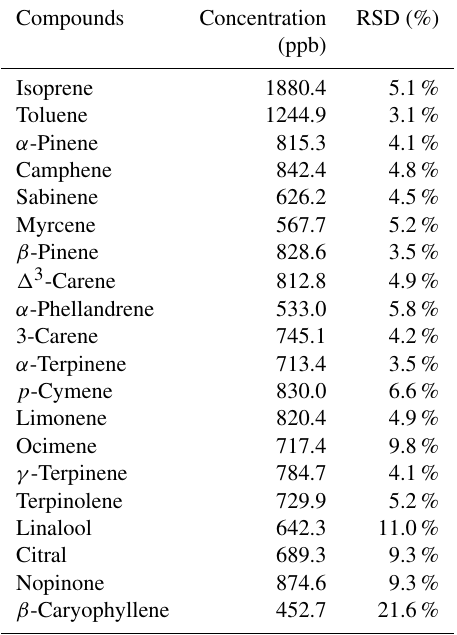
Table 4. Canister reproducibility ( n = 7). RSD refers to the relative standard